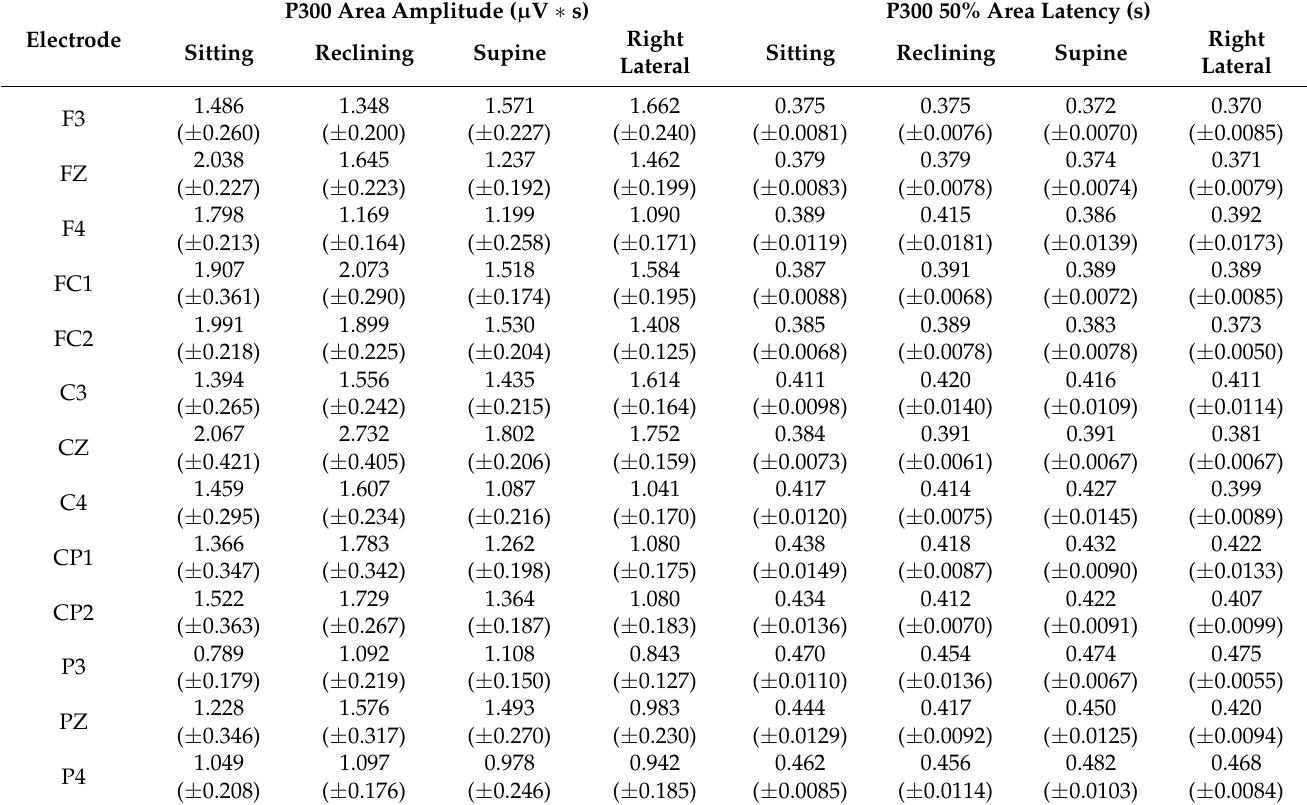
Table A1. Area amplitude ( µ V ∗ s) and 50% area latency (s) for the P300 in each posture (mean ± standard error).